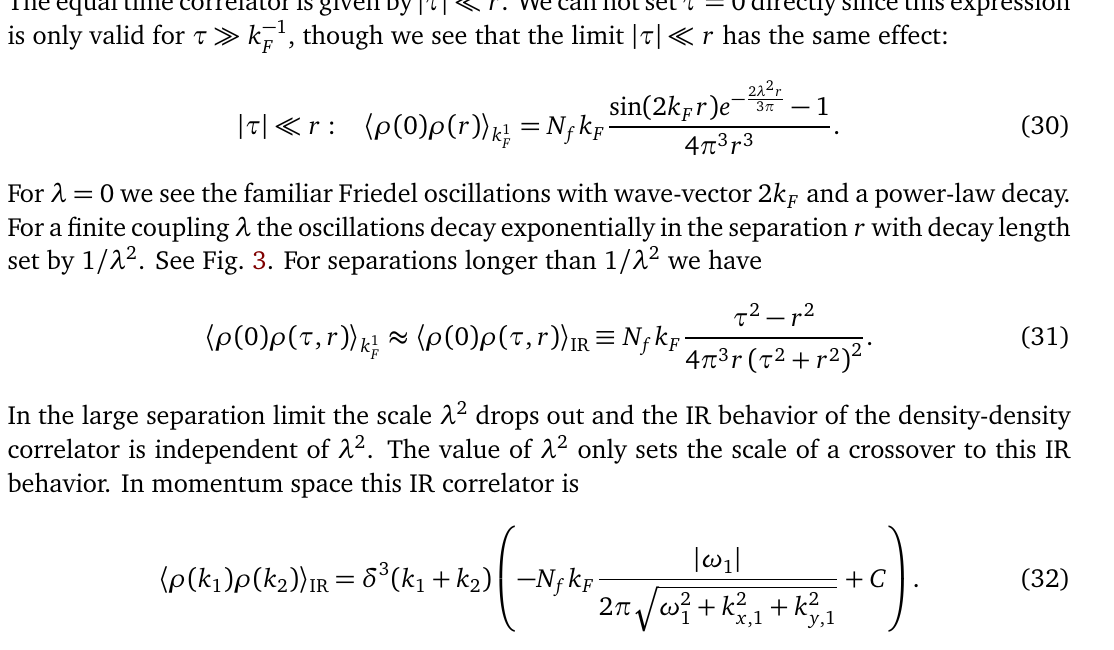
Figure 3: Equal time density-density correlator. This result is only valid for λ 2 (cid:28) k note that for any finite λ the correlator exponentially approaches the λ = ∞ case for large separations r